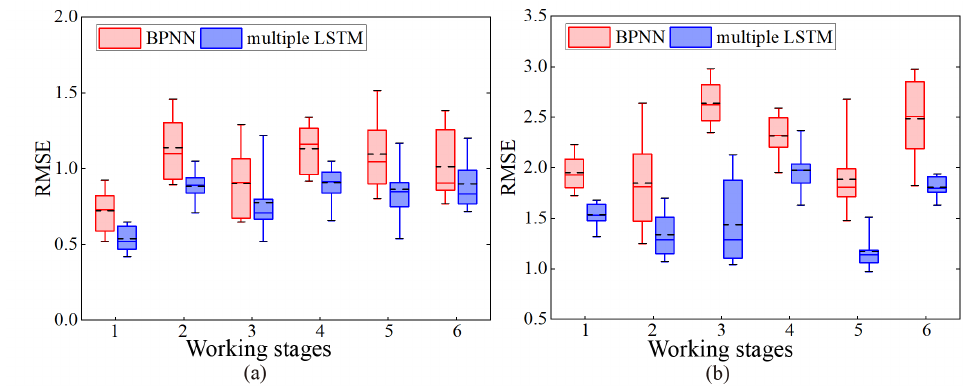
Figure 11. RMSE comparison of different LSTM networks using large coarse gravel: ( a ) prediction of throttle value ( b ) prediction of state.